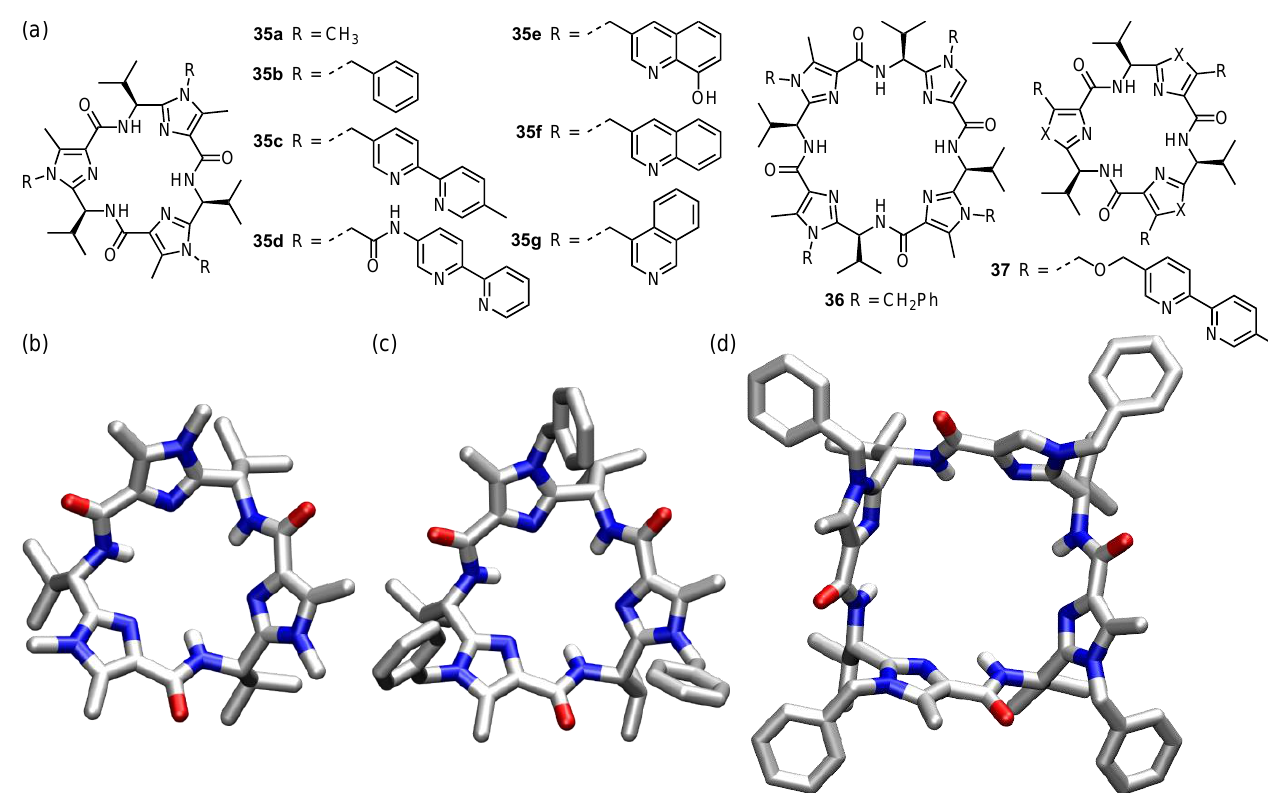
Figure 17. Structures of cyclopeptides 35a – g , 36 , and 37 ( a ), and crystal structures of 35a (CSD Entry: LUBKEY) ( b ), 35b (CSD Entry: HAHNEK) ( c ), and 36 (CSD Entry: XIBDES) ( d ). Solvent molecules, and protons, except acidic ones, are omitted for reasons of clarity.